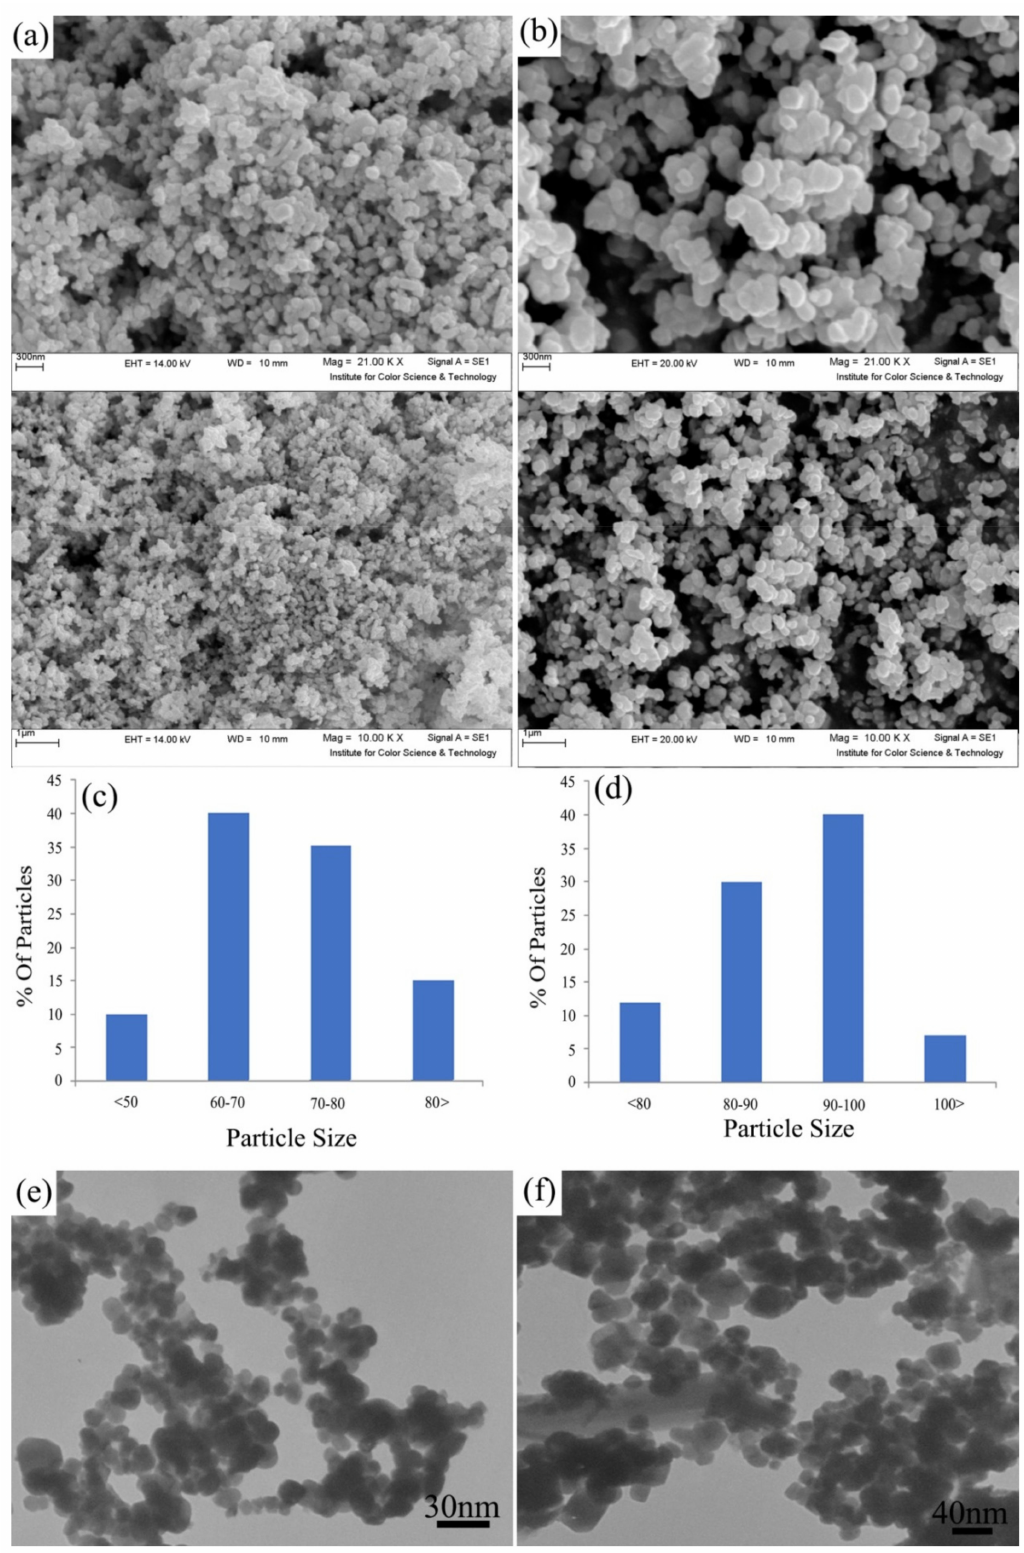
Figure 1. ( a , b ) The SEM images, ( c , d ) particle size distribution and ( e , f ) HRTEM images of the ( a,c,e ) Fe 3 O 4 / CdWO 4 (S1) and ( b,d,f ) Fe 3 O 4 / CdWO 4 / PrVO 4 (S4)